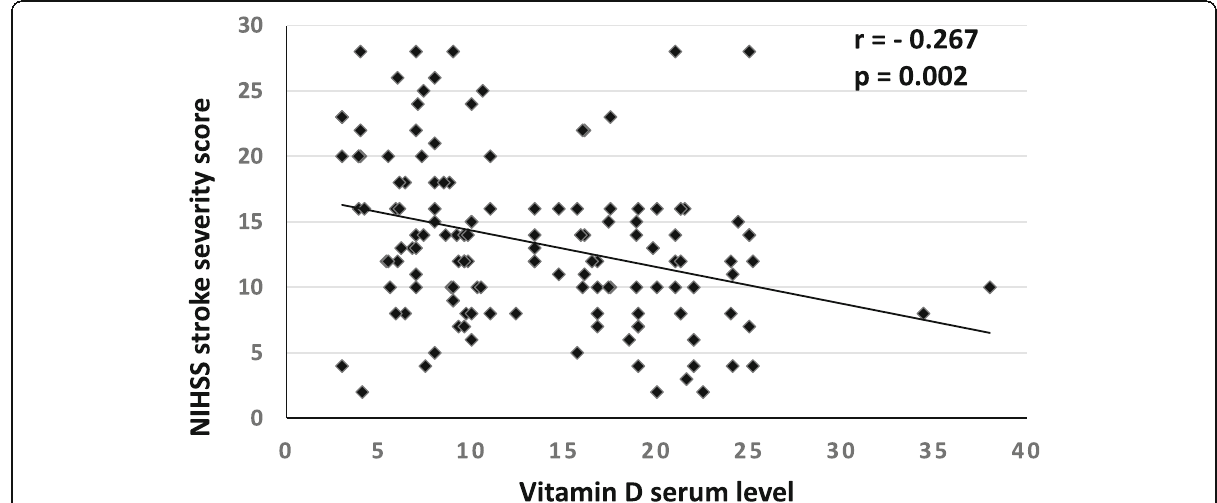
Fig. 1 Partial correlation analysis after controlling for age, dyslipidemia, and infarction size shows that vitamin D serum level (ng/ml) demonstrated significant negative correlation with NIHSS stroke severity score